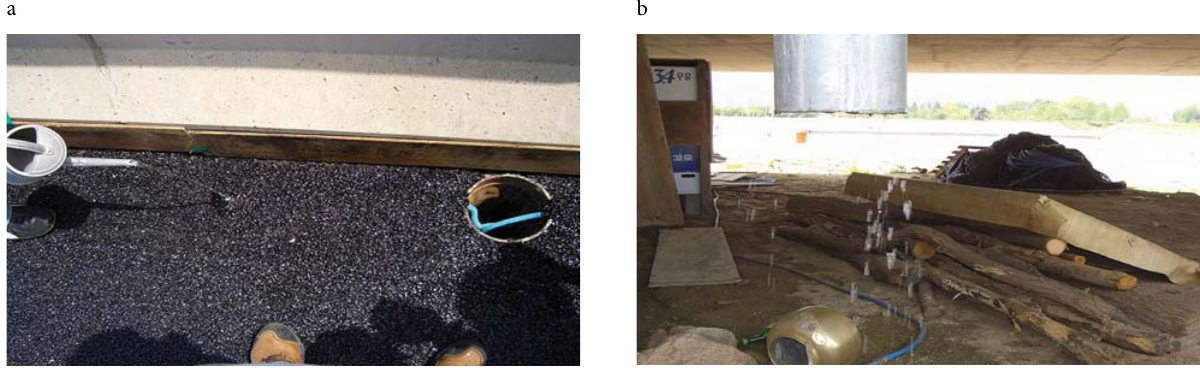
Fig. 9. Investigation of in-field permeability of the porous asphalt mixtures: a – spraying water on the draining layer; b – drainage of infiltrated water through the drain